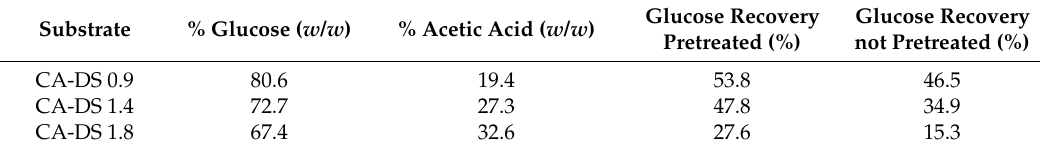
Table 2. Glucose recovery with Cellic C Tec 3 after esterase pretreatment and without pretreatment of CA with different degrees of substitution. Cellulose acetate with a degree of substitution of 0.9 (CA-DS 0.9). The degree of substitution refers to the number of acetyl groups per glucose unit in the molecule. Substrate % Glucose ( w / w ) % Acetic Acid ( w / w )